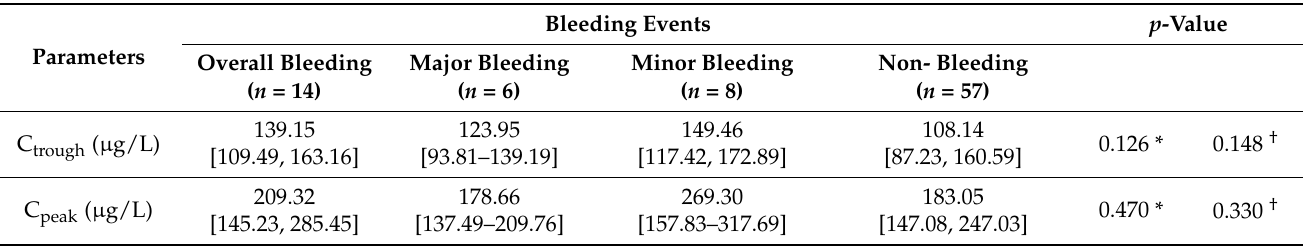
Table 4. The trough and peak values of the apixaban plasma levels classified by bleeding events.